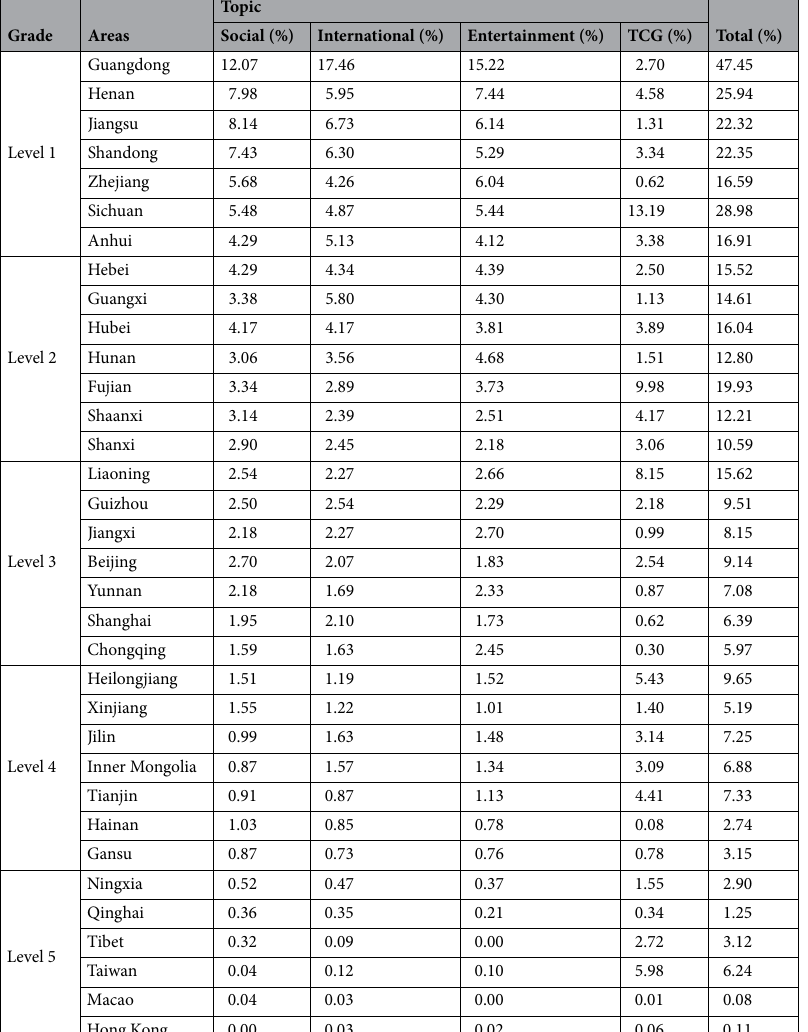
Table 4. User’s spatial location hierarchy